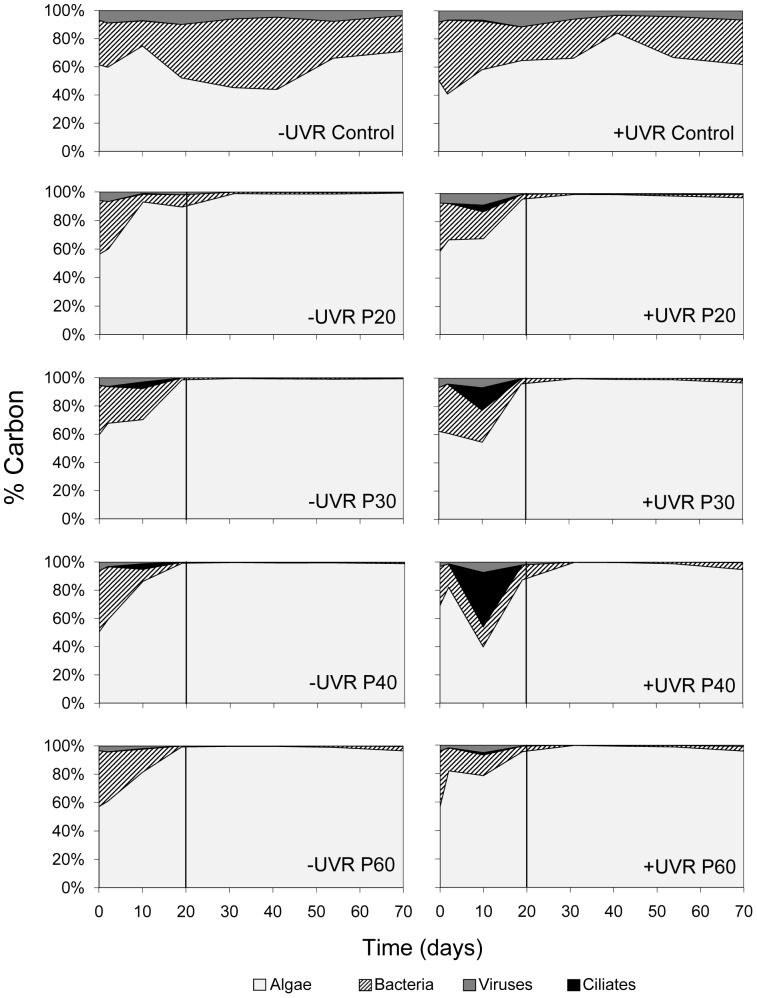
Biomass variation of each fraction of the planktonic community (<40 µm) over the experiment.Treatments with full sunlight radiation (+UVR; left panels) and without UV radiation (−UVR; right panels), as well as treatments without (Control) and with nutrient addition (20, 30, 40 and 60 µg P L−1) are displayed. The values are expressed as percentage of carbon. The vertical line divides experimental periods with or without availability of dissolved inorganic P.